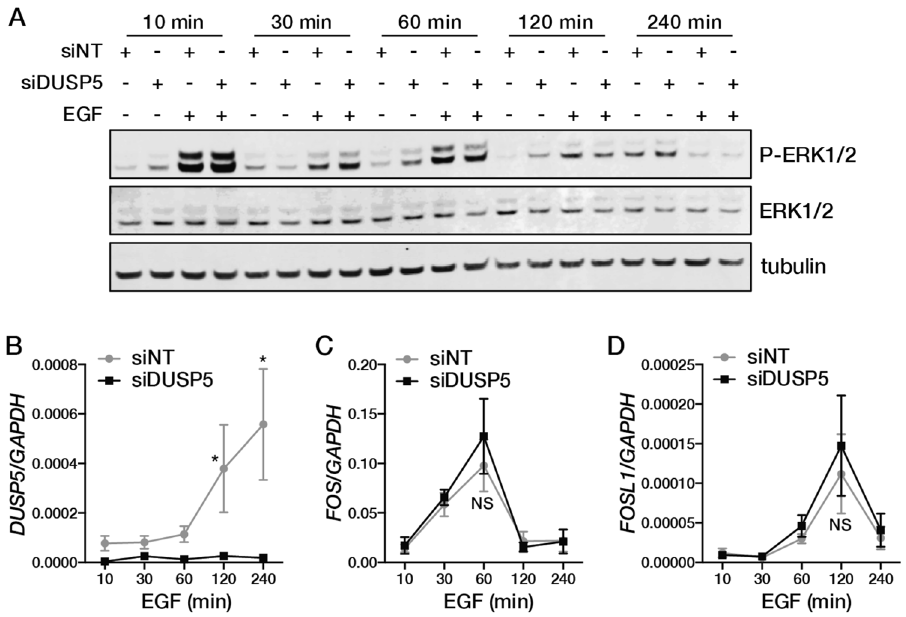
Figure 5. DUSP5 regulation of EGF-induced ERK signalling in CRC cells. Effect of DUSP5 knockdown on induction of ( A ) ERK1/2 phosphorylation, and mRNA levels of ( B ) DUSP5 , ( C ) FOS , and ( D ) FOSL1 following treatment of LIM1215 cell with EGF (50